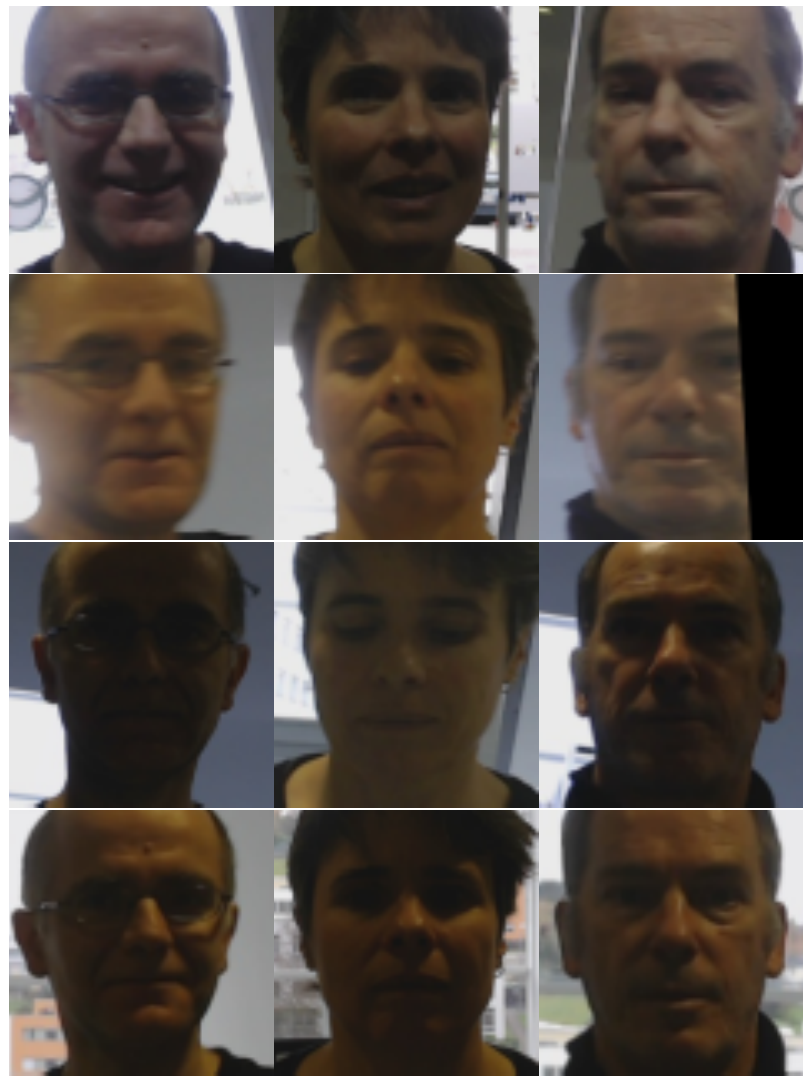
Figure 7. Samples after face normalization captured on different floors evidencing variations in pose and illumination across floors. Each column corresponds to a specific participant (Identities 1, 2, 3, 6, and 7) and shows one acquisition per